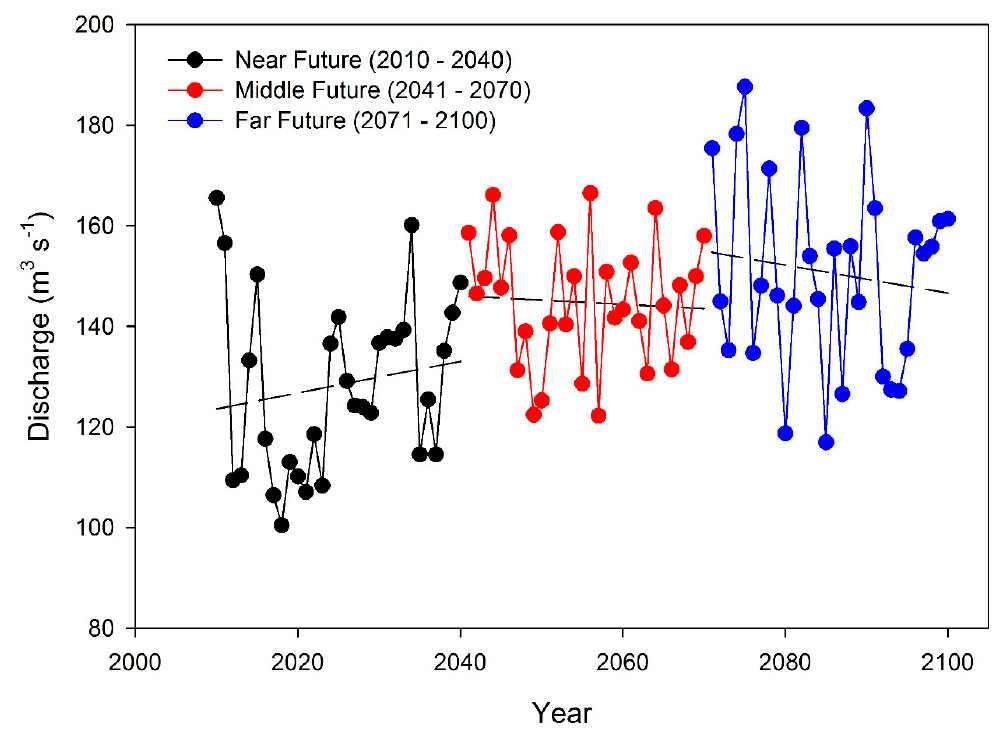
Figure 12. The trend of Yearly projected average discharge for near (2010–2040), middle (2041–2070) and future (2070–2100) under RCP4.5 climate change scenarios for the Astore River at the Doiyan gauge station.